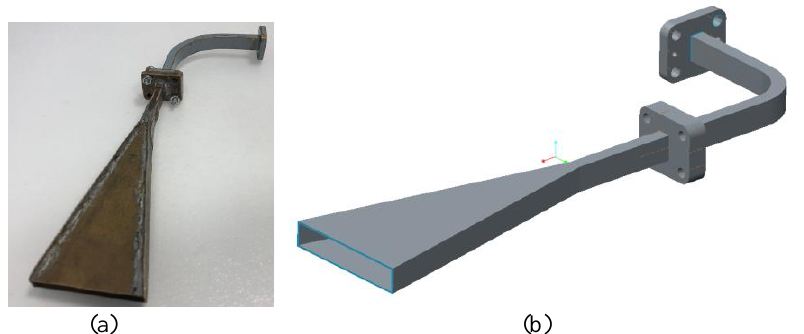
Fig. 1. Prototype (a) and 3D model (b) of a waveguide transition with an H-sectorial horn developed in PTC Creo Parametric.